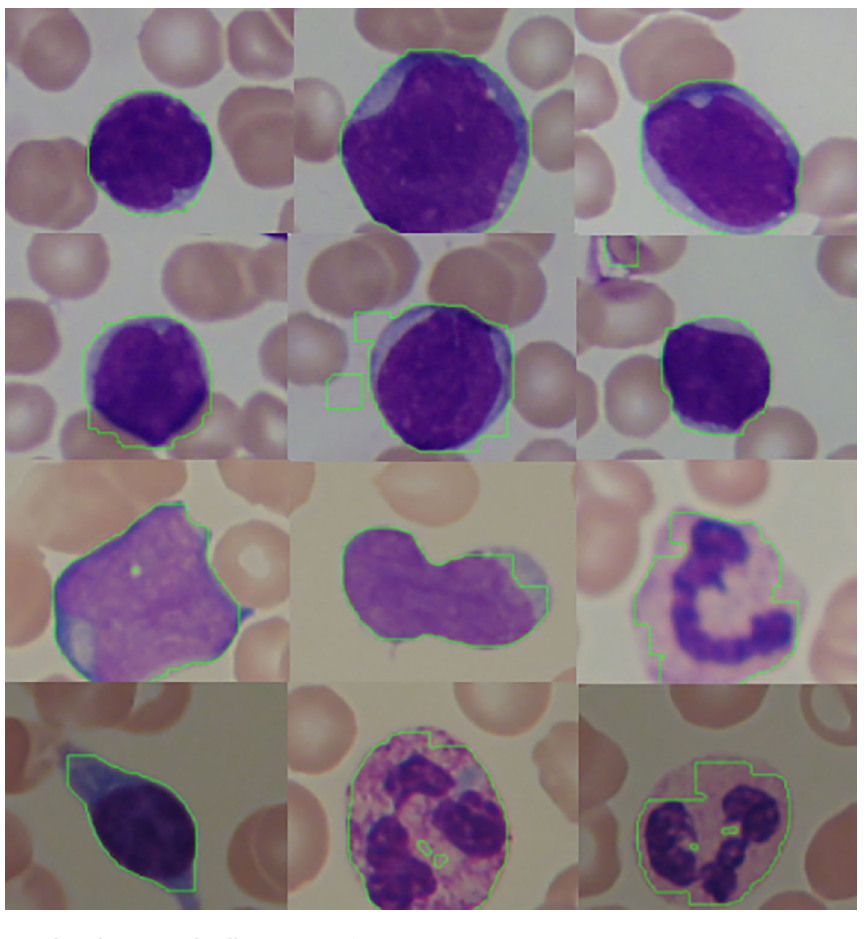
Figure 14. Results of proposed cell segmentation.